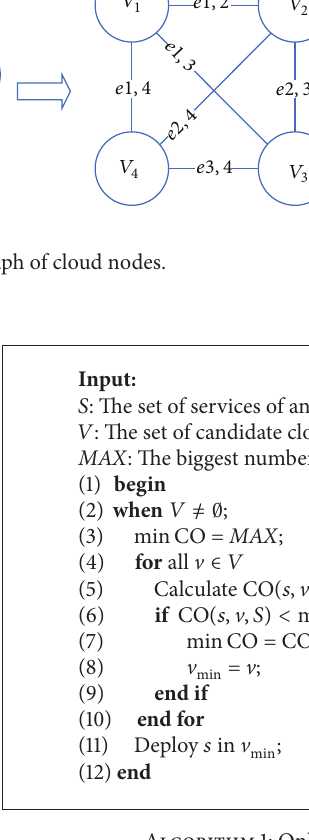
Figure 3: System architecture. Algorithm 1: Online